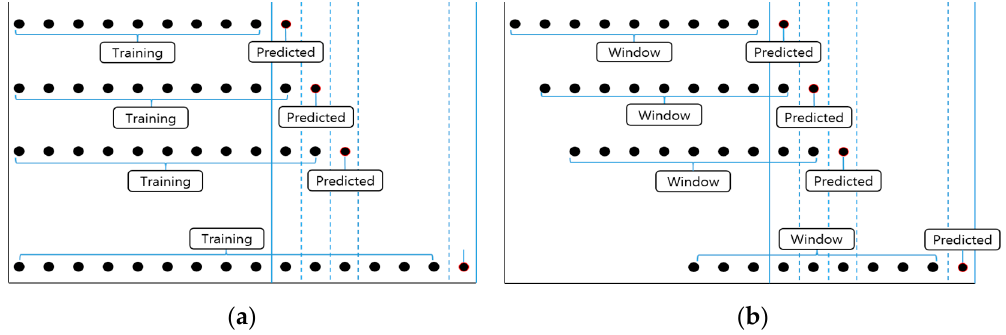
Figure 9. 1–step ahead recursive prediction; the input data were added to the model step by step during model construction for future prediction. ( a ) Cumulative learning and ( b ) rolling window learning.